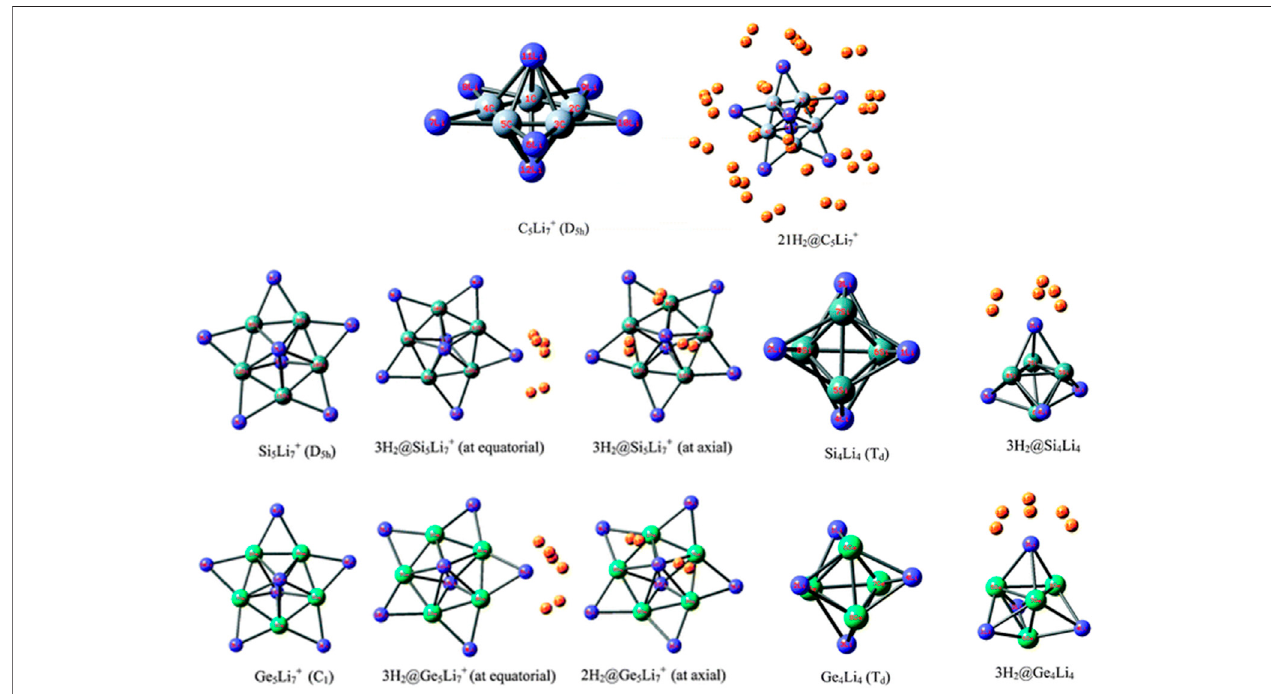
FIGURE 13 | Optimized structures of C 5 Li 7+ , M 5 Li 7+ , M 4 Li 4 (M (cid:1) Si, Ge) and their H 2 -trapped analogues at the M06/6-311+G(d,p) level. (Adapted from Pan et al., 2012b with permission from the PCCP Owner Societies.).